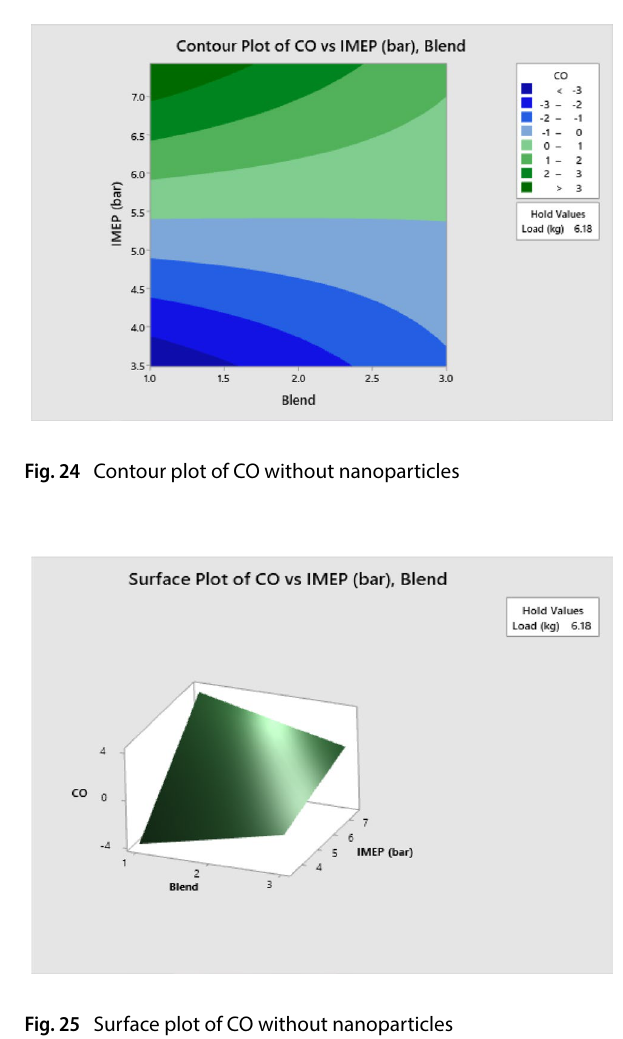
Fig. 28 Contour plot of CO